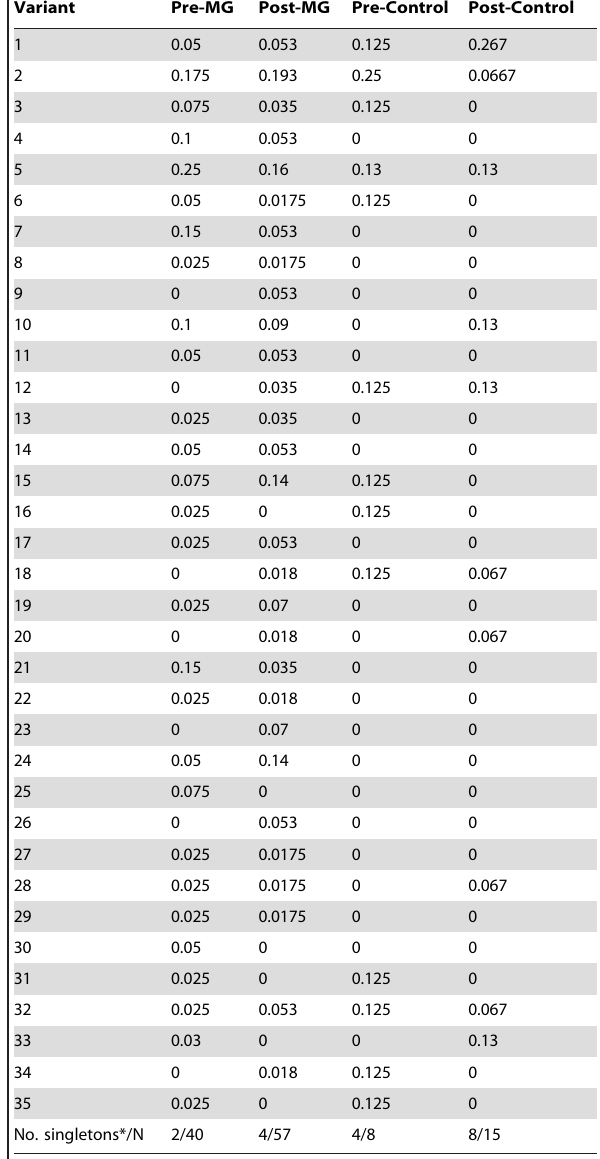
Table 2. The frequencies of DNA variants of a fragment of exon 2 of the class II MHC detected in the sampled house finch populations.